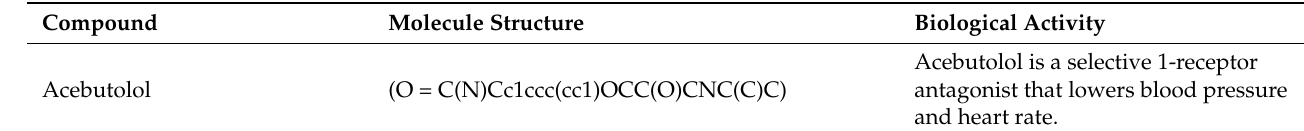
Table 4. Summary of the compounds identified using our